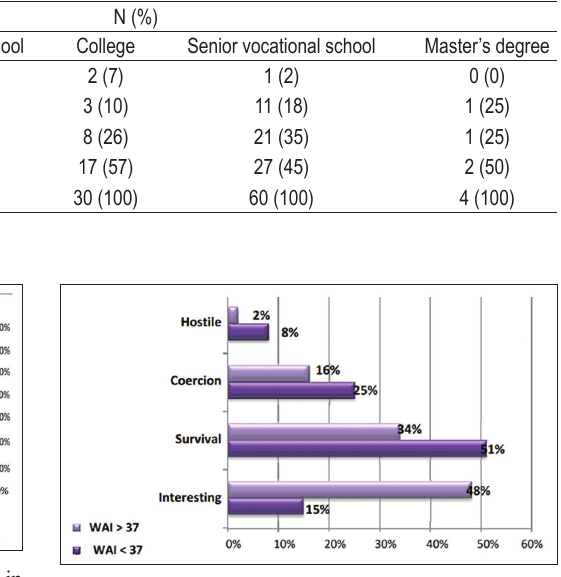
FIGURE 6. Work ability and subjective work experience. The employees with bad work ability experienced their profession and situation at work as hostile 6 (8%), coercion 18 (25%), and a mean to survive (36 [51%]). However, 96 (48%) employees with good work ability perceived it as interesting.